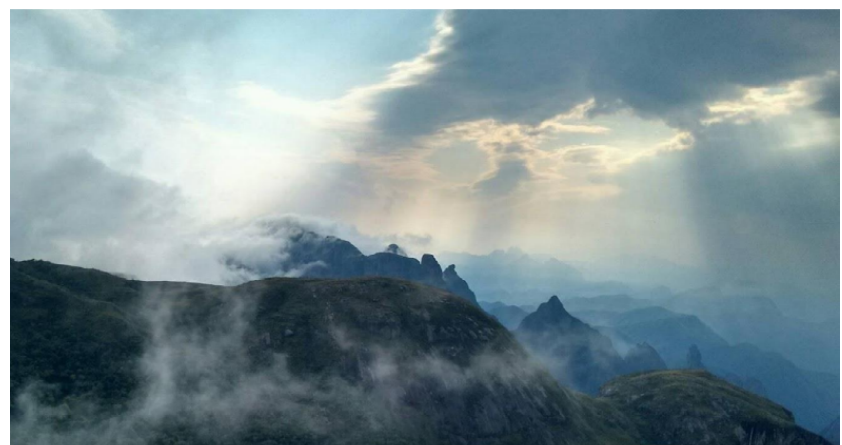
Figure 14. Second day trail